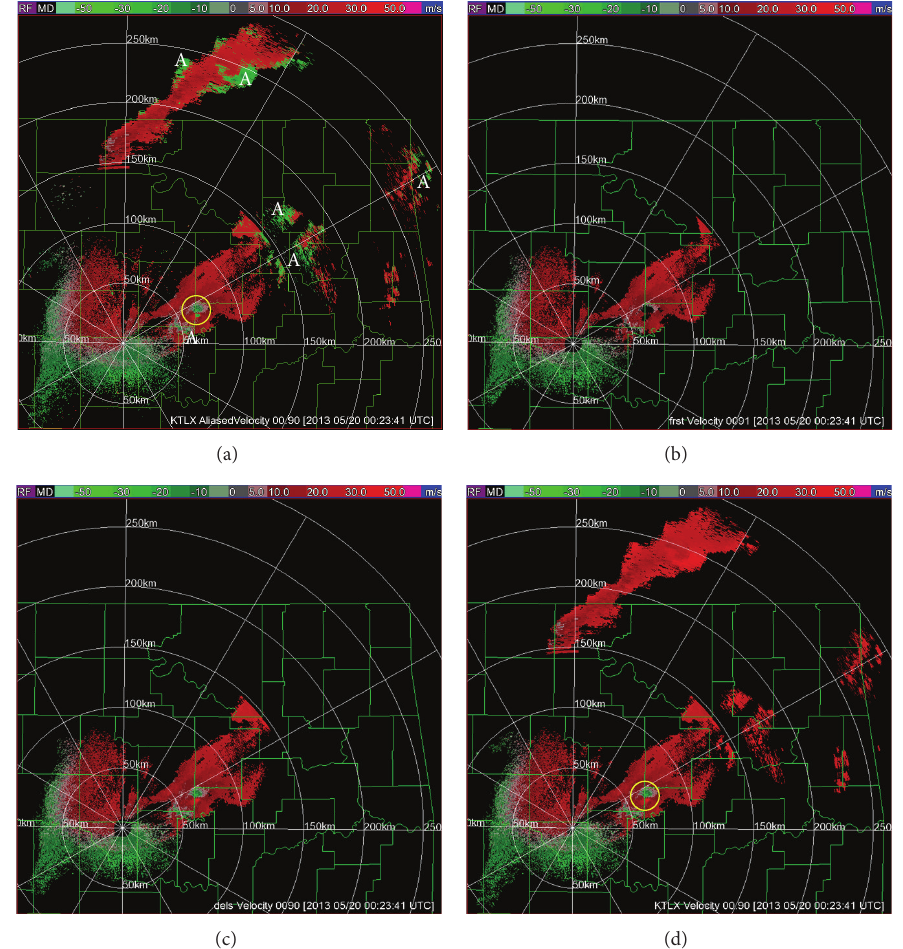
Figure 4: Raw radial-velocity image scanned by the KTLX radar using VCP12 with V 𝑁 = 26.1ms −1 at 0.9 ∘ tilt for the Shawnee, Oklahoma tornadic storm at 00:23:41 UTC on May 20, 2013 (local time 7:23:41 pm, on May 19, 2013). (b) Dealiased radial-velocity image produced by the first one-way forward procedure in the continuity check. (c) Final dealiased radial-velocity image produced by the new extended AR-Var- based method. (d) as in panel (d) but the first guess is from the RAP-predicted wind field for the refined AR-Var analysis. The white letters “A” in panel (a) mark the main aliased-velocity areas. The yellow circle in panels (a) and (d) encircles the mesocyclone and its produced EF4 tornado that struck Shawnee, Oklahoma, in the evening (local time around 6:45 pm) on May 19,